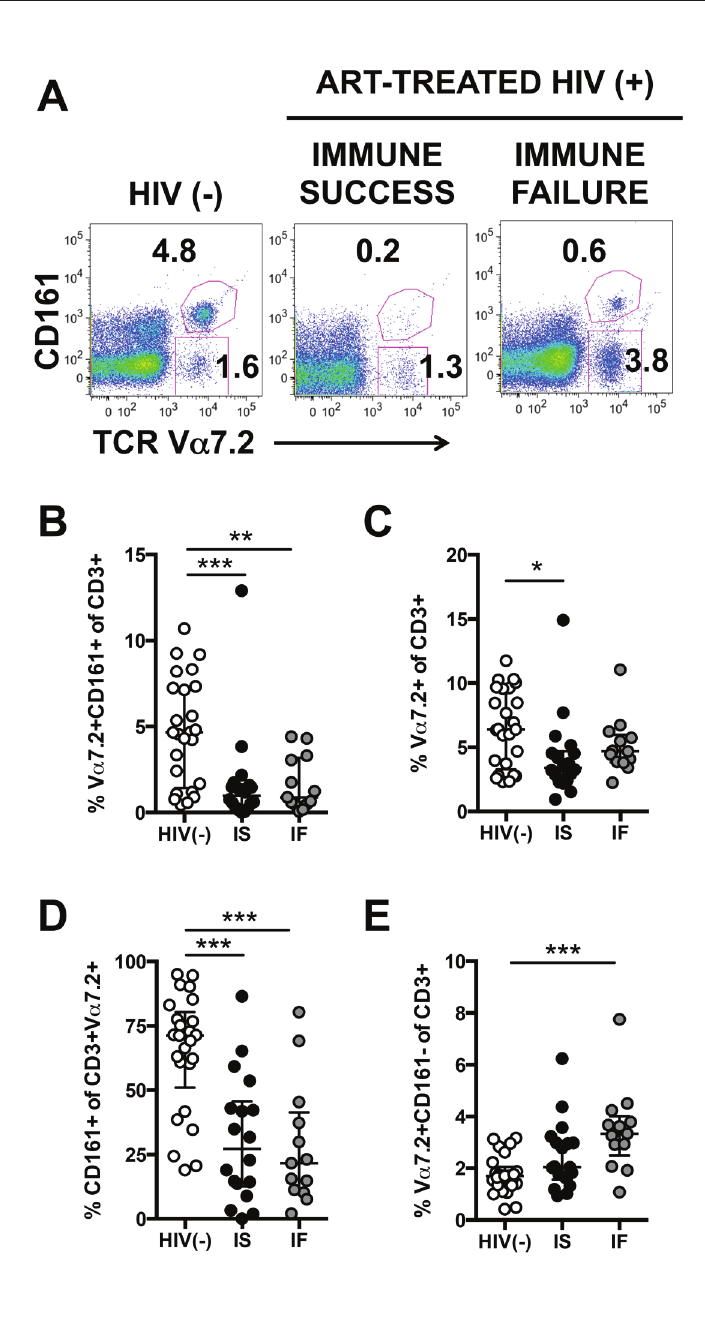
Figure 1. Loss of Vα7.2 + CD161 + Cells in ART-Treated HIV Infection. (A) Representative plots show CD161 and TCR Vα7.2 expression on CD3 + cells from HIV-uninfected or ART-treated HIV-infected do- nors. (B) The percentage of CD3 + cells that are Vα7.2 + CD161 + (Kruskal-Wallis test). (C) The percentage of CD3 + cells that are Vα7.2 + (Kruskal-Wallis test). (D) The percentage of CD3 + Vα7.2 + cells that are CD161 + (Kruskal-Wallis test). (E) The percentage of CD3 + cells that are Vα7.2 + CD161- (Kruskal-Wallis test). * P ≤ 0.05; ** P ≤ 0.01; *** P ≤ 0.001. ART, antiretroviral therapy; IS, Immune Success; IF, Immune